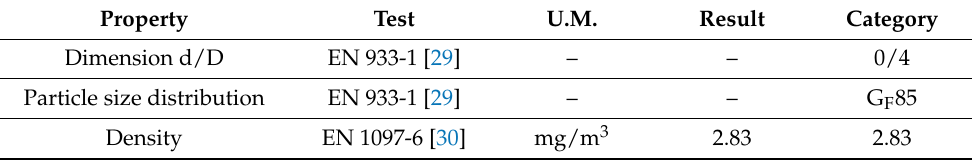
Table 2. Properties of aggregate VA 0/4.